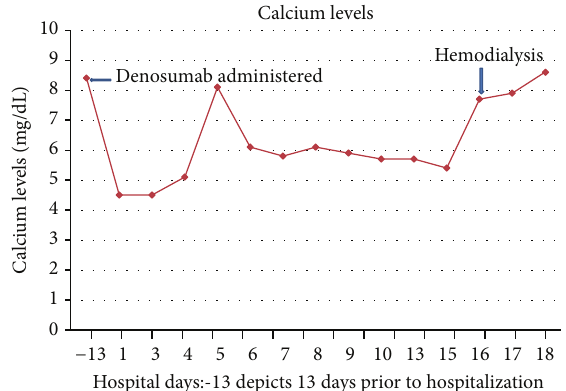
Figure 1: Calcium levels while in the hospital remaining low despite ergocalciferol, calcitriol, and high doses of IV and oral calcium supplementation.